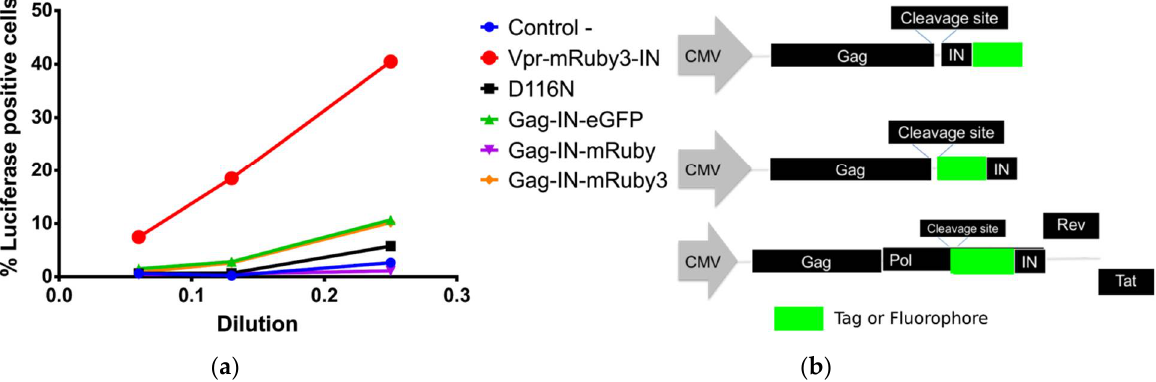
Figure 1. ( a ) C-terminal fusions to IN are integrase deficient while N-terminal IN fusions restore infectivity in HeLa cells with catalytically inactive IN from pNL4-3HIV-1 molecular clone. ( b ) Schematic organization of the fused constructs used in this study.